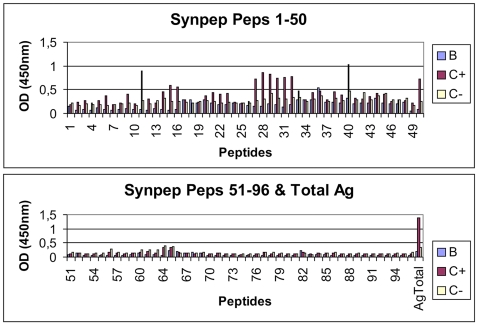
IgG-specific activities of synthetic peptides of DENV-3 E-glycoprotein, using human sera.The horizontal axis denotes the peptide number and the vertical axis denotes the absorbance measured at 450 nm. The cut-off absorbance used to identify reactive epitopes is shown by the red line. Ag, antigen; Peps, peptides; B, blank; C+, positive control; C-, negative control.